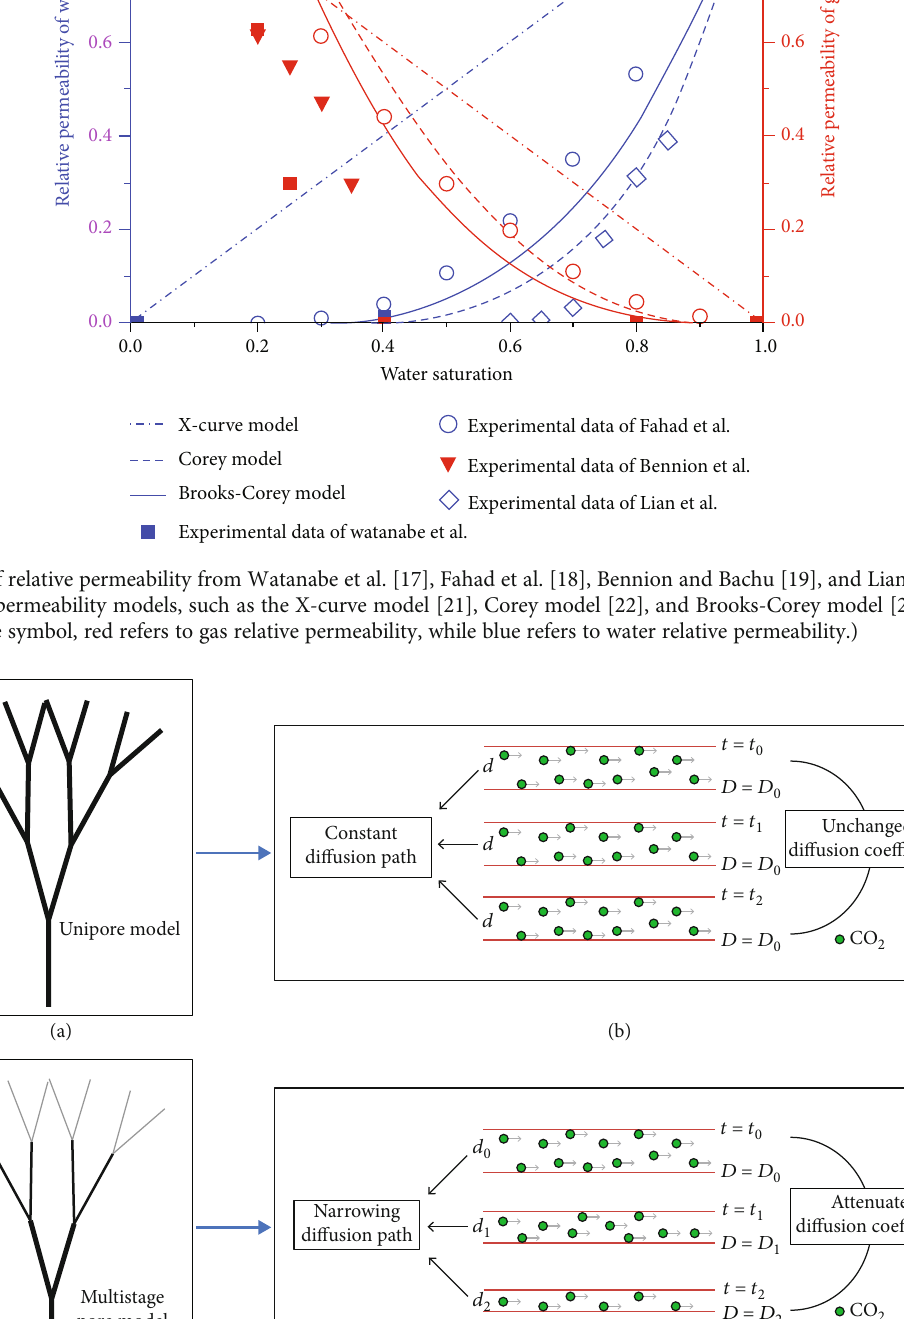
di ff usion in coal matrix 2